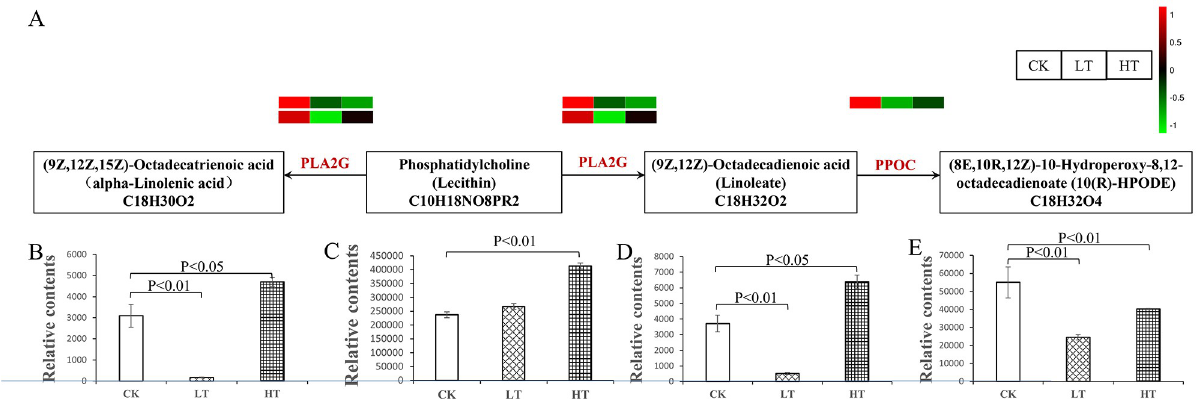
Fig 9. DEGs involved in the linoleic acid biosynthetic pathways, and the metabolite changes in response to temperature stress. (A) The expression pattern of the DEGs involved in the linoleic acid biosynthetic pathways. The changes in (B) alpha-linolenic acid (C 18:3 ), (C) lecithin, (D) linoleate (C 18:2 ), and (E) 10(R)-HPODE (C 18:2 ) in response to temperature stress. The bars represent the average ( ± SD.) of three biological replicates. P < 0.01 and P < 0.05 were considered levels of statistical significance. PLA2G, phospholipase A2. PPOC, linoleate 10R-lipoxygenase. DEGs, differentially expressed genes. LT, samples incubated at 22˚C. CK, samples incubated at 30˚C. HT, samples incubated at 42˚C.